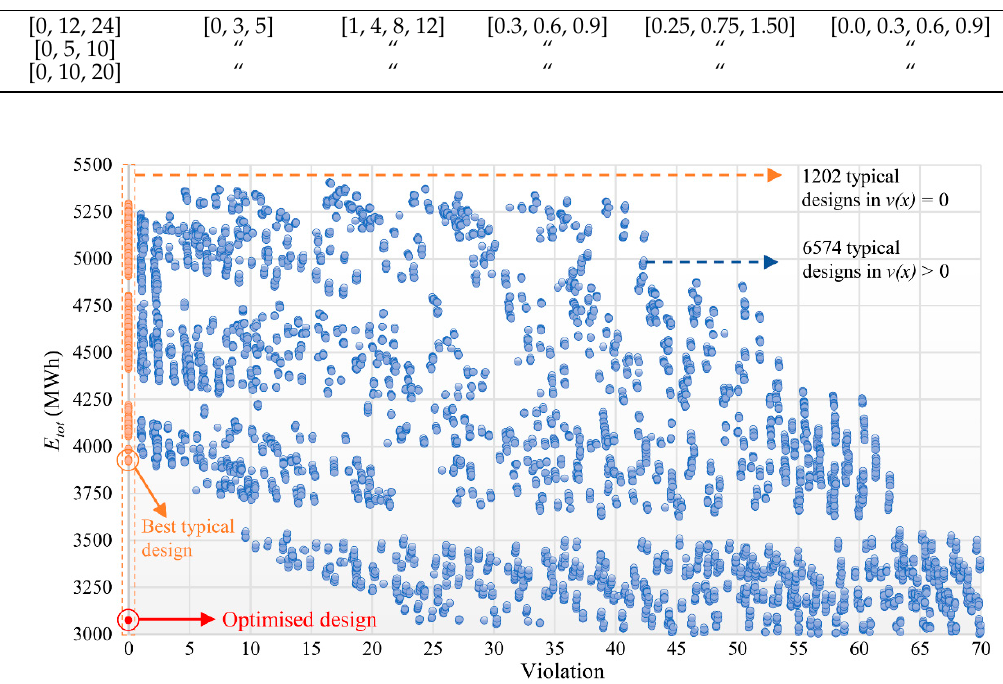
Table 9. Parameter values used to generate typical scenarios.